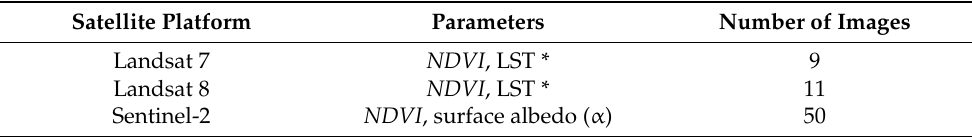
Table 3. Parameters and number of images from remote sensing data. Satellite Platform